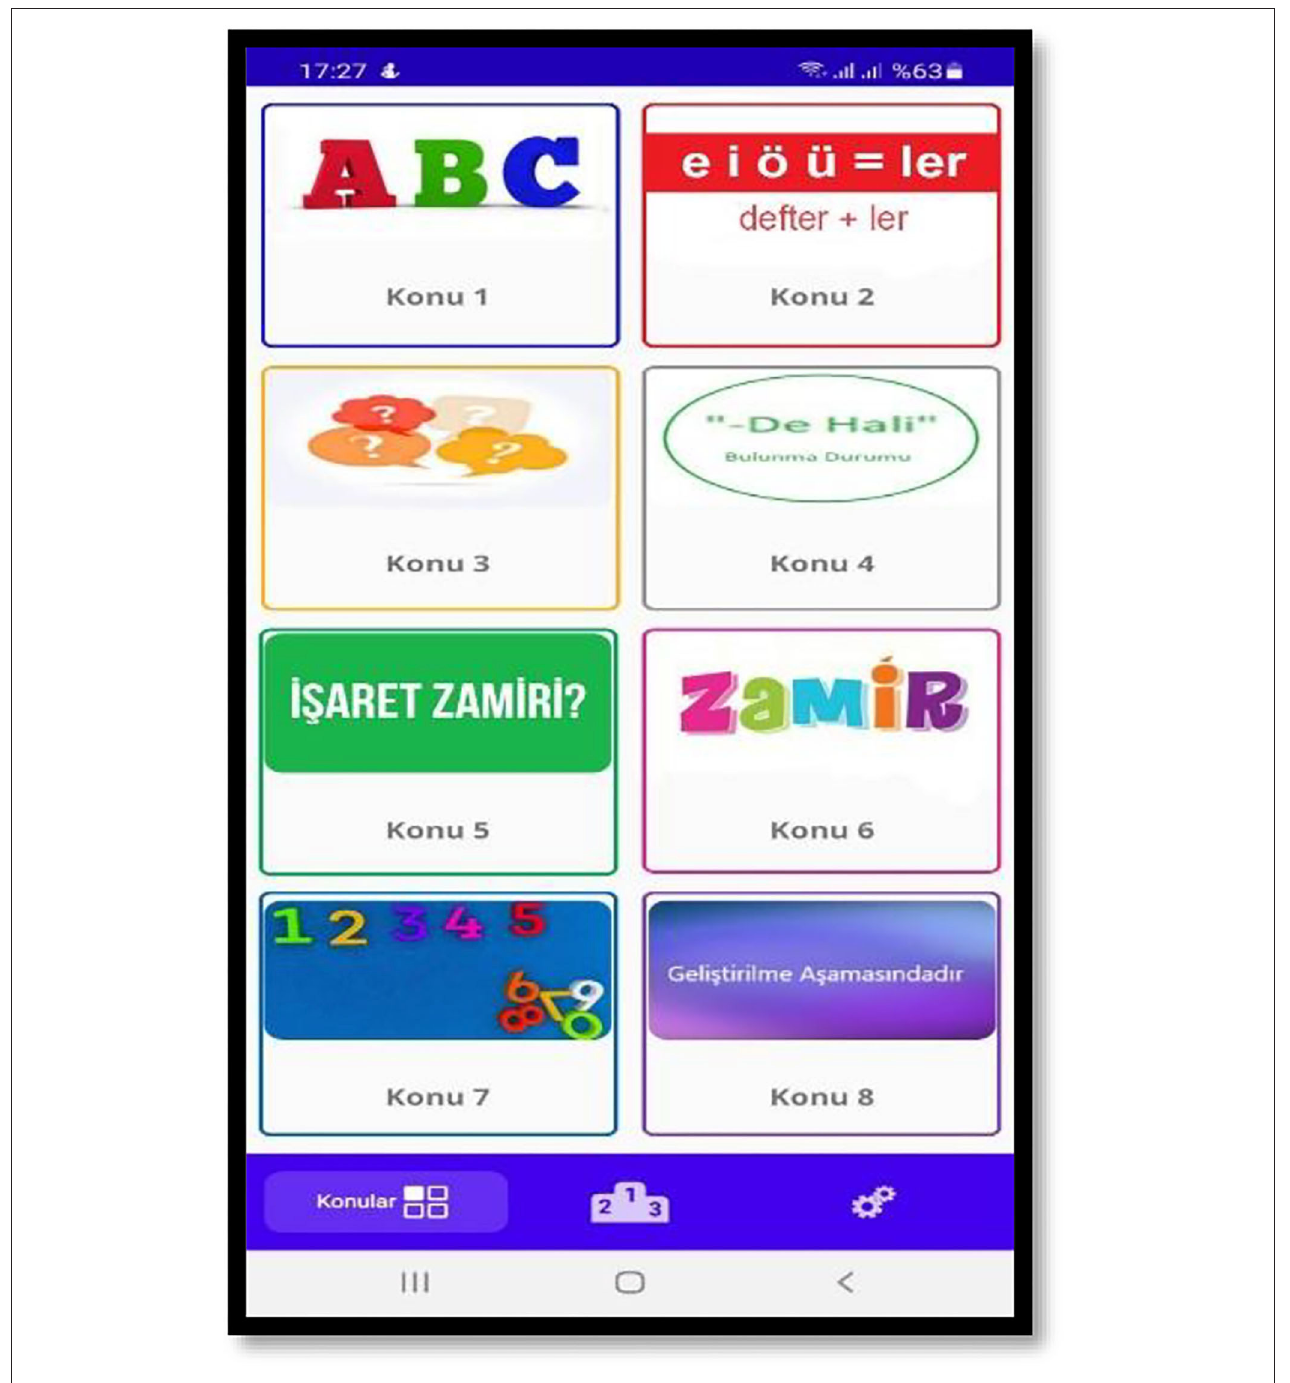
FIGURE 2 | Main menu of the